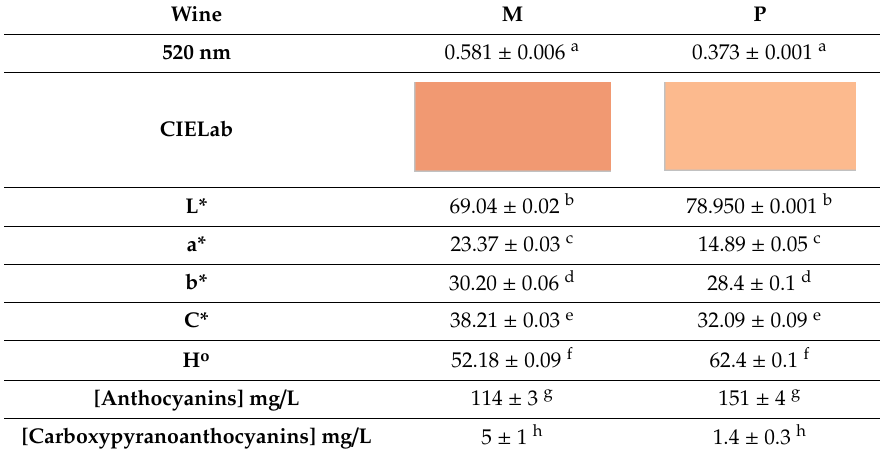
Table 1. Red color index absorbance measurement at 520 nm and CIELab parameters obtained by MSCV coordinates program (2 mm glass path cell). Anthocyanins and carboxypyranoanthocyanins concentration obtained by High Performance Liquid Chromatography (HPLC) and express in mg / L.